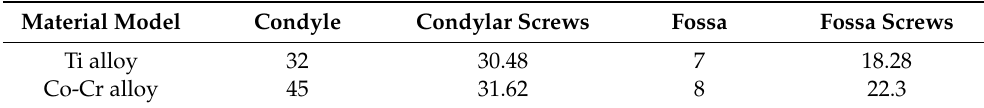
Table 3. Maximum von-Mises stresses values in MPa for two different materials model in customized TMJ